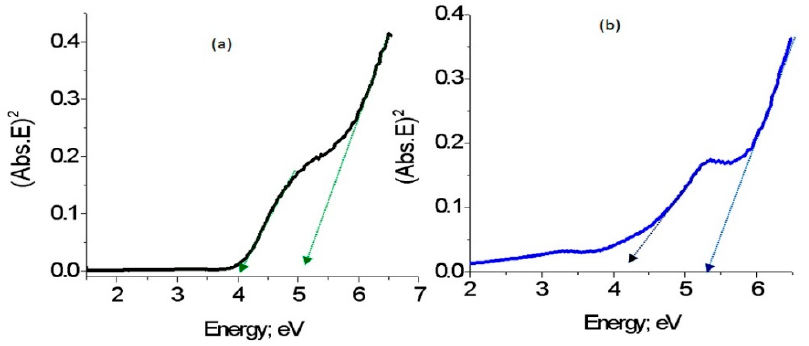
Appl. Sci. 2020 , 10 , x FOR PEER REVIEW Figure 11. Band gap energy of ( a ) Zn-Al LDH, and ( b ) Zn-Al-GO1. Figure 11. Band gap energy of ( a ) Zn-Al LDH, and ( b ) Zn-Al-GO1.